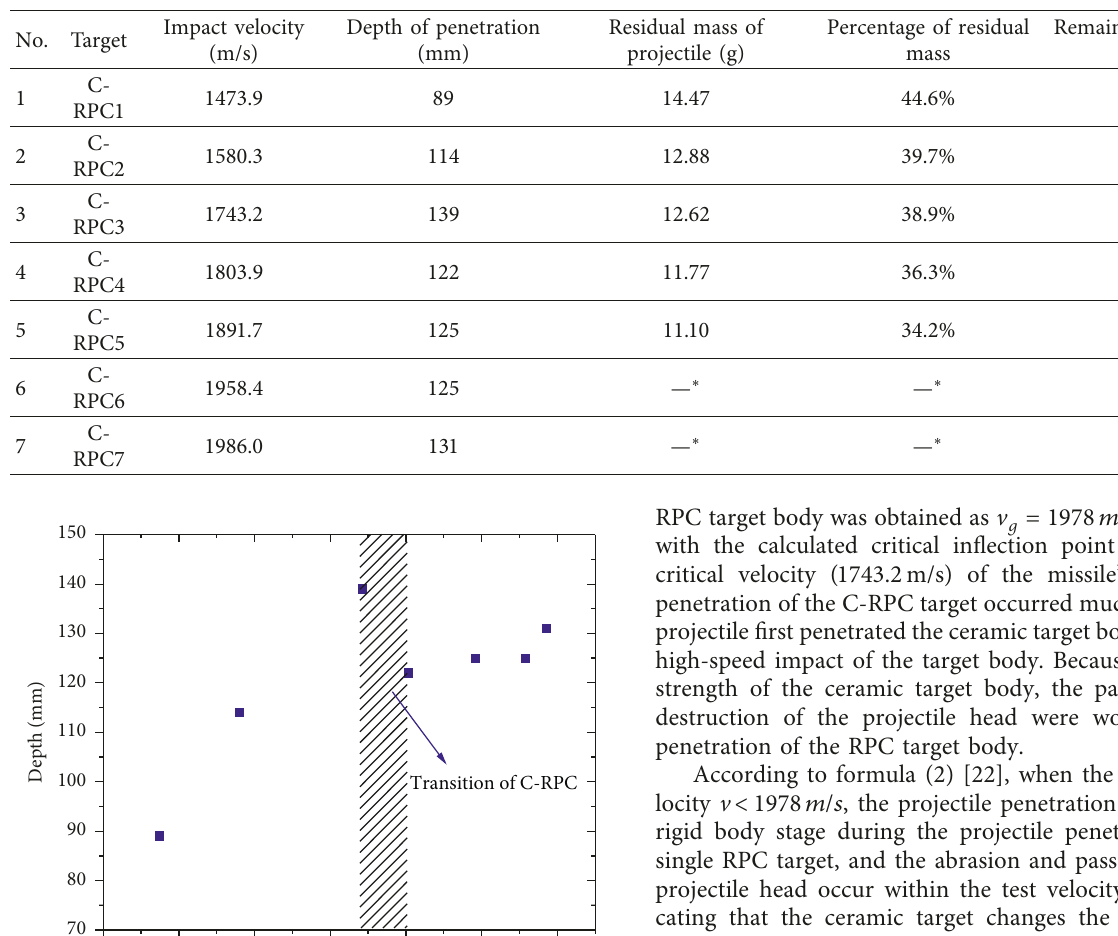
Table 2: Experimental results.